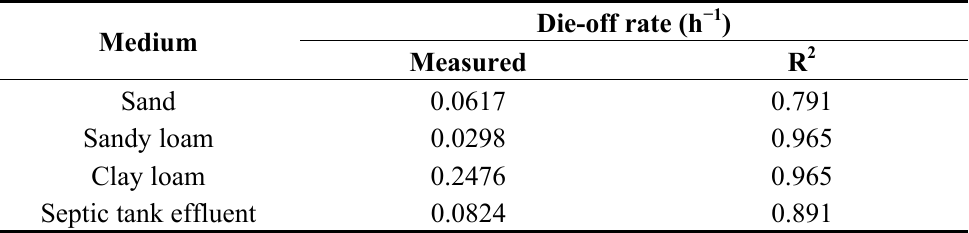
Table 4. Measured GFP E. coli die-off rates in soil and septic tank effluent.